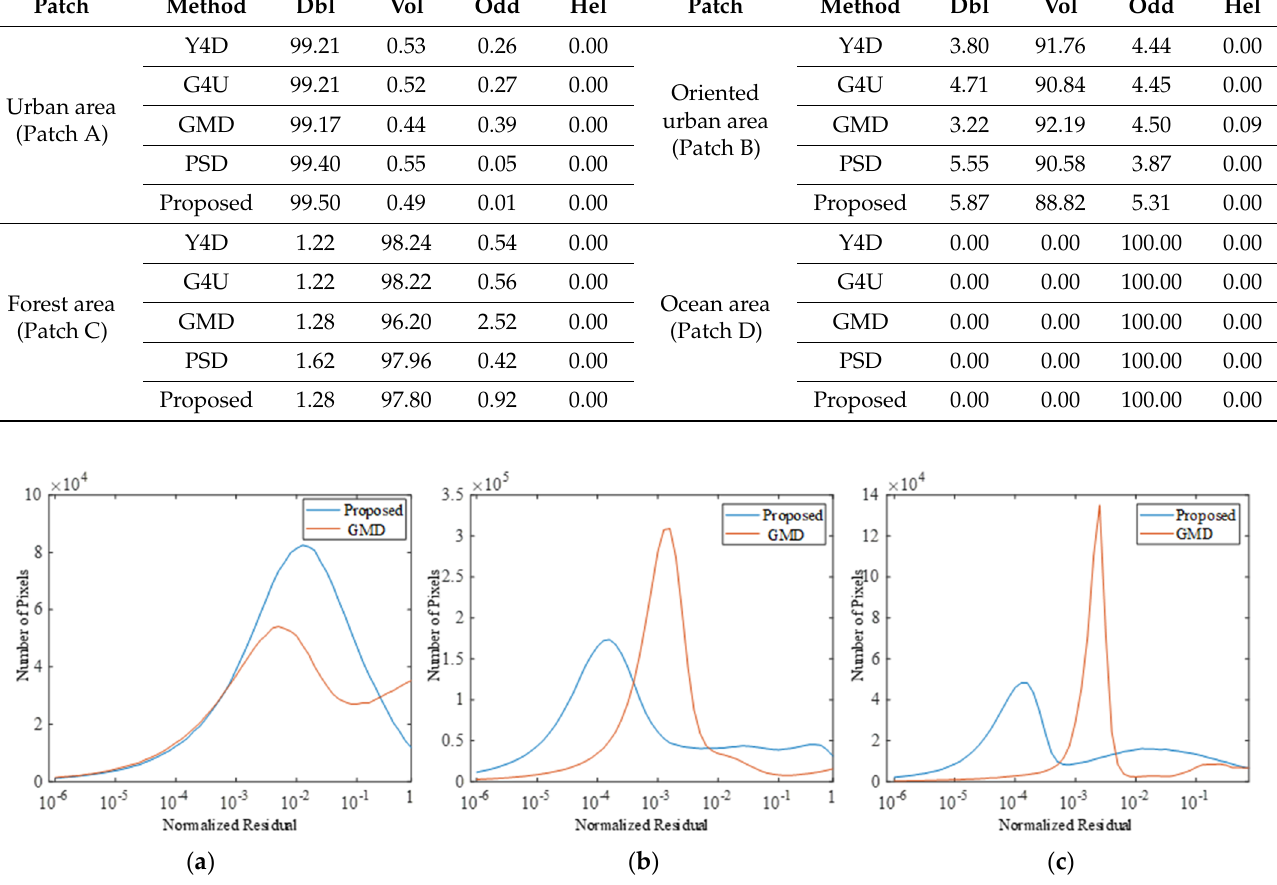
Figure 10. Histograms of the normalized residuals. ( a ) PiSAR data. ( b ) Radarcat-2 data. ( c ) ALOS-2 data.